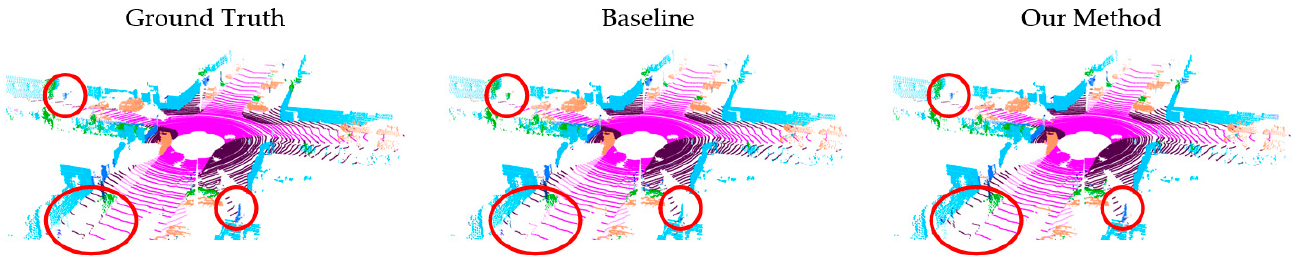
Figure A1. Visual comparison with baseline on full test set.